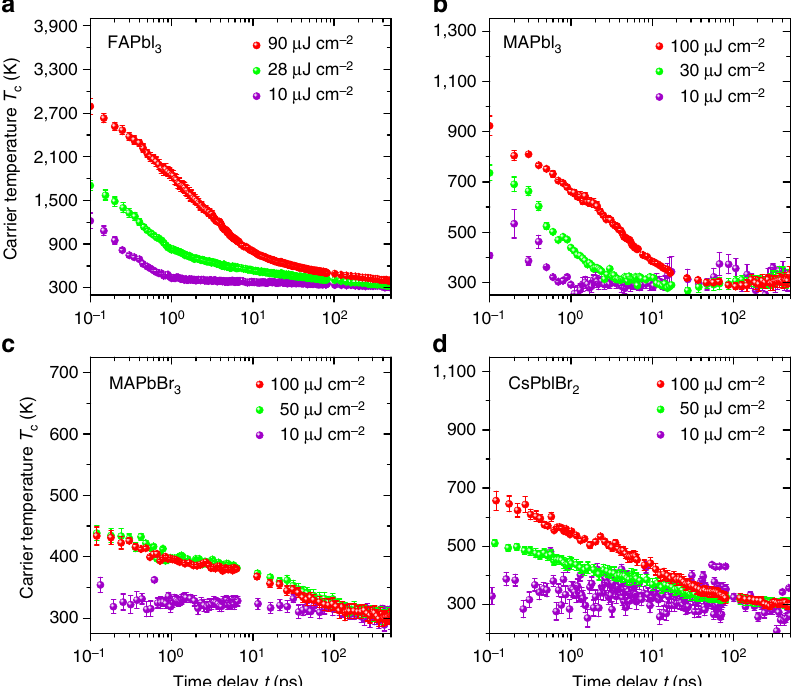
Figure 2 | Time-dependent carrier temperature under different incident fluence. In ( a ) FAPbI 3 , ( b ) MAPbI 3 , ( c ) MAPbBr 3 , ( d ) CsPbIBr 2 . The carrier temperatures are extracted by fitting the high-energy tail of the bleaching in the TA spectra. The error bar shows the standard error of the average (s.e.m.) fitting